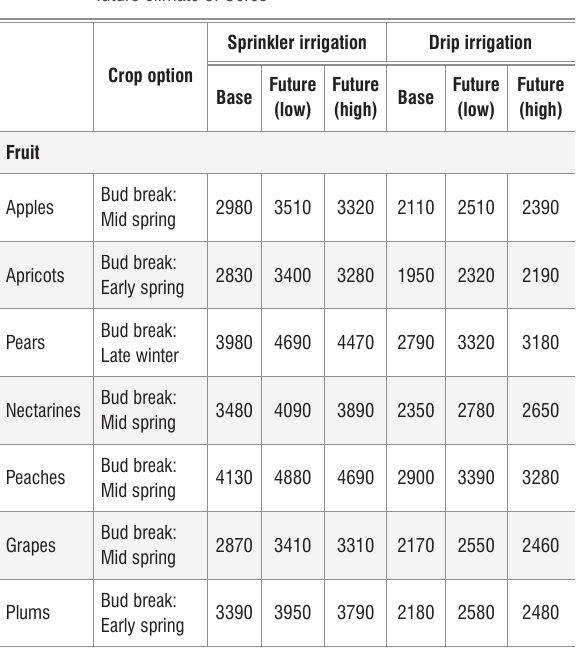
Estimated crop water requirement (m 3 /ha) for the base and future climate of